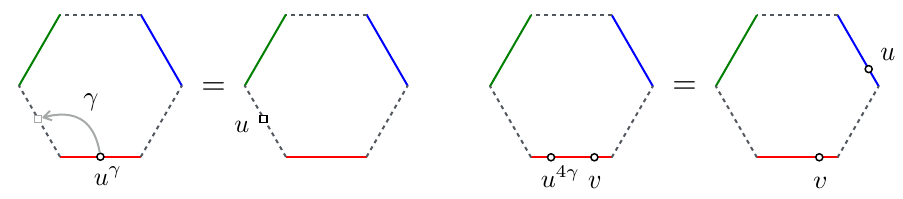
Figure 2 . We can move an excitation around by using the mirror rotation (cid:13) . The latter maps rapidities, (cid:13) : u ! (cid:13) ( u ) (cid:17) u (cid:13) , from the real to the mirror kinematics. In a relativistic theory, the mirror rotation coincides with an euclidean boost by 90 degrees, (cid:13) : (cid:18) ! (cid:18) (cid:13) = (cid:18) + i(cid:25)= 2. For the N = 4 spin chain, it consists in analytically continuing the rapidity u to the second sheet of the p Zhukowski rapidity x + = x ( u + i ), with x = ( u + u 2 (cid:0) 4 g 2 ) = 2 g . One can move the excitation 2 farther away on the hexagon, through further analytical continuations, as illustrated in the right panel for a 4 (cid:13) = 360 (cid:14)